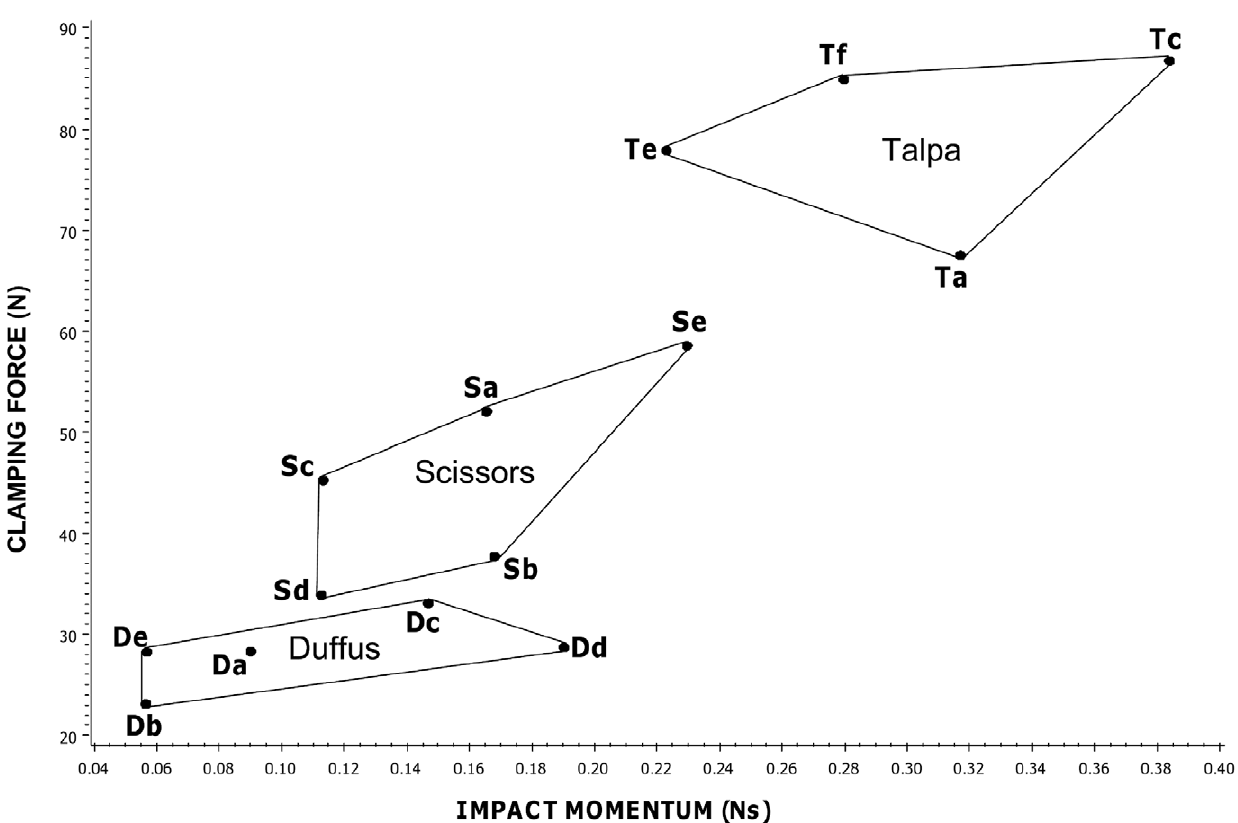
Figure 3. Impact momentum against clamping force for mole traps. Each point represents a different trap type/manufacturer combination and is the mean of measurements on 10 individual traps for impact momentum and 20 traps for clamping force. Points for traps of the same type but from different manufacturers are enclosed within a polygon. Points marked Da-e represent Duffus traps (n=5), those marked Sa-e represent scissors traps (n=5) and those marked Ta,c,e,f represent talpa-style traps (n=4). Letters a-f represent different